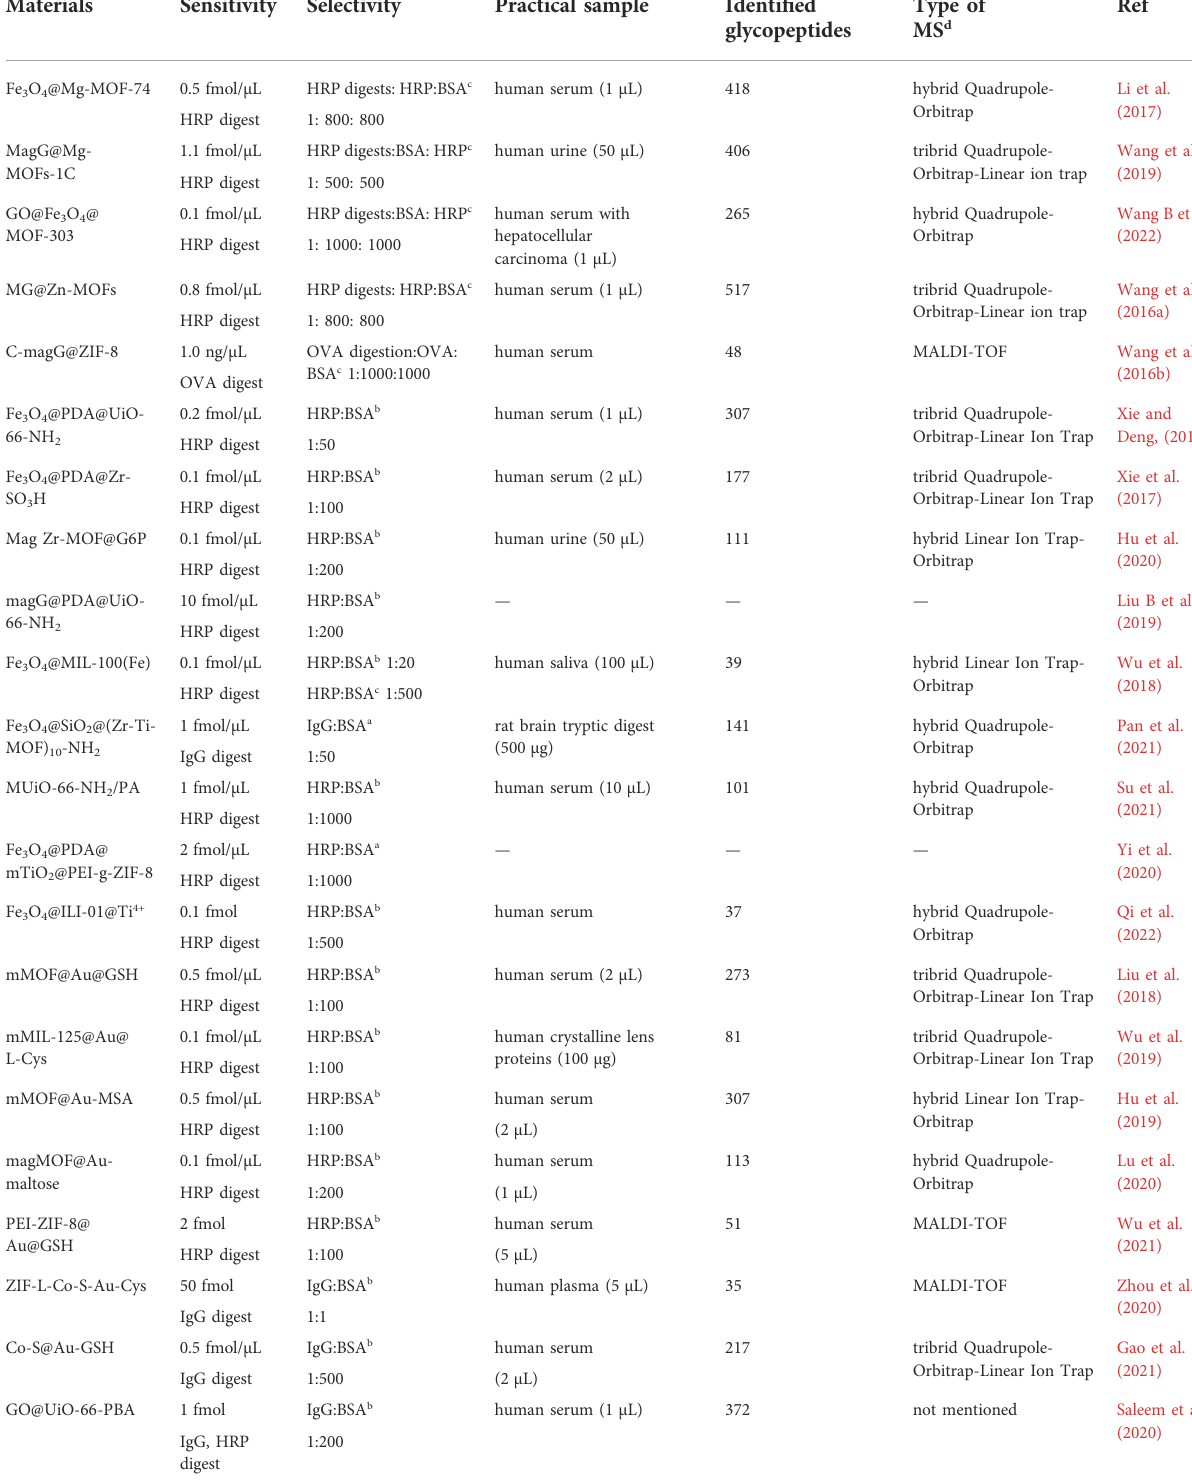
TABLE 3 Representative display of MOFs-derived composites in glycoproteomics.